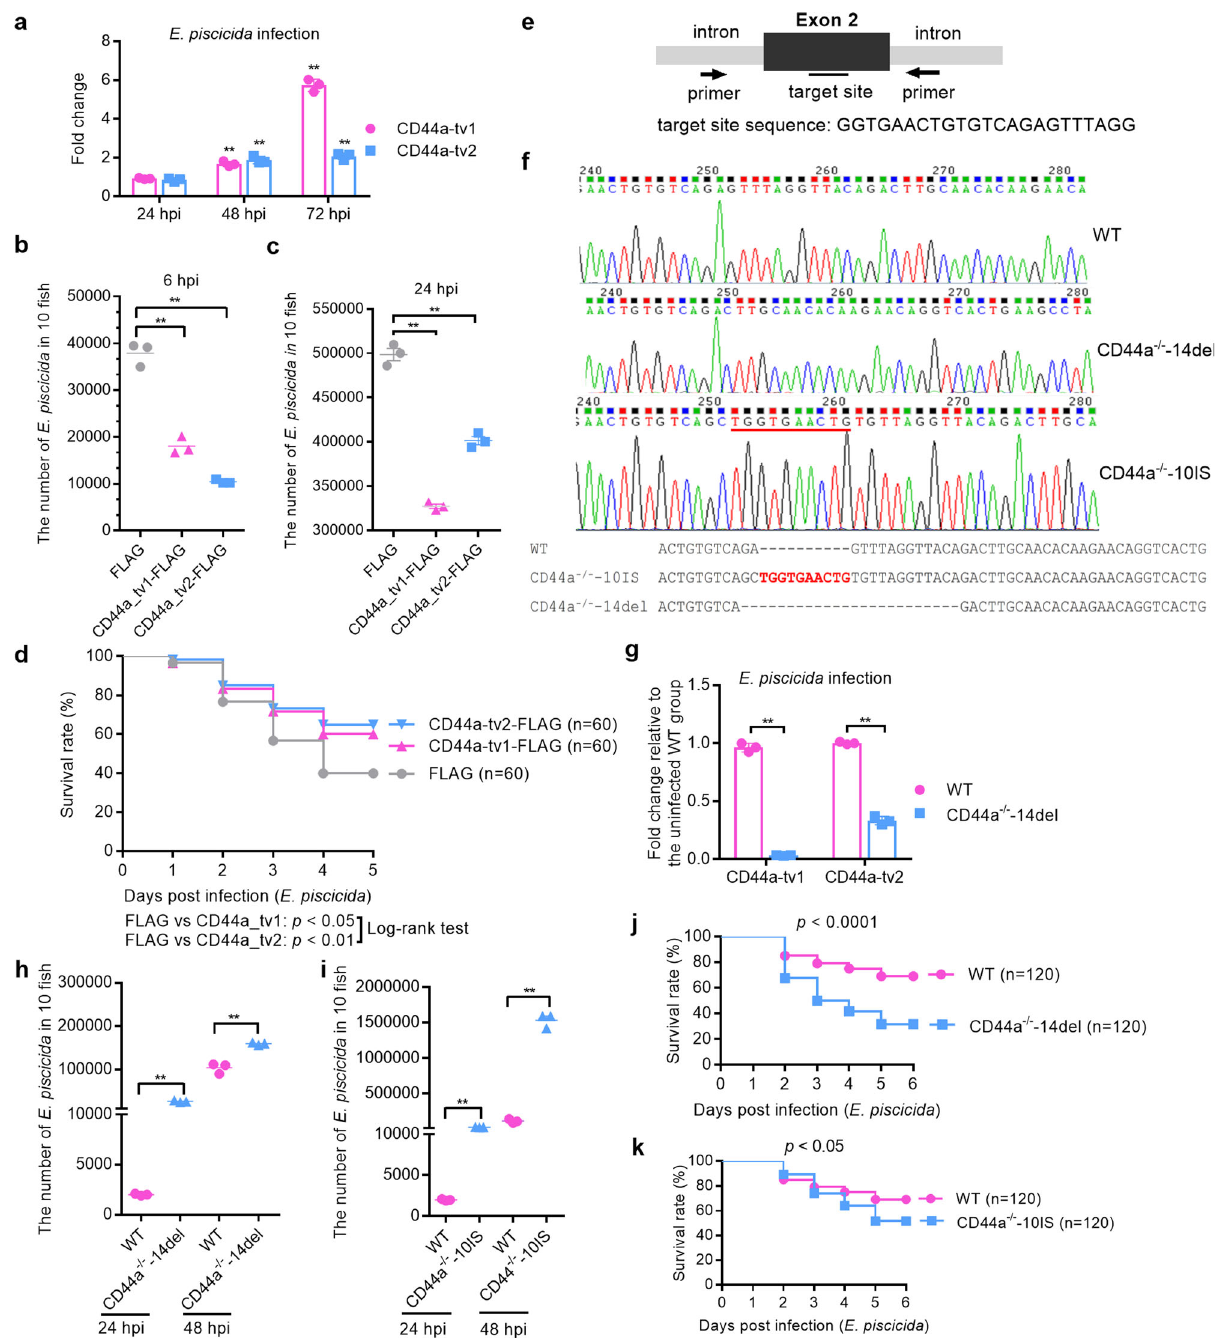
Fig. 1 Zebra fi sh CD44a plays a critical role in protecting against E. piscicida infection. a The effect of E. piscicida infection on the expression of CD44a variants in zebra fi sh larvae. b , c The antibacterial effects of zebra fi sh CD44a variants at 6 and 24 hpi. d Larval survival analysis in the WT zebra fi sh microinfected with FLAG, CD44a_tv1-FLAG or CD44a_tv2-FLAG ( n = 60 for each group). e Cartoon showing the position of the target site and its sequence in the zebra fi sh CD44a locus. f Representative Sanger sequencing results of the PCR amplicons from homozygous mutations with 14 bp deletions (CD44a − / − -14del), 10 bp insertions (CD44a − / − -10IS) or WT. g The expression of CD44a variants in the WT and CD44a − / − -14del zebra fi sh larvae. h Zebra fi sh larvae from the WT and CD44a − / − -14del mutants were collected at the indicated post-infection time points, and homogenates were made for CFU counts. i Zebra fi sh larvae from the WT and CD44a − / − -10IS mutants were collected at the indicated post-infection time points, and homogenates were made for CFU counts. j Larval survival analysis in the WT and CD44a − / − -14del zebra fi sh larvae infected with E. piscicida ( n = 120 for each group). k Larval survival analysis in the WT and CD44a − / − -10IS zebra fi sh larvae infected with E. piscicida ( n = 120 for each group). For b , c , h and i , each symbol represents the average counts of ten larvae. For a – c and g – i , the data are presented as means ± SD ( n = 3). ** p < 0.01.